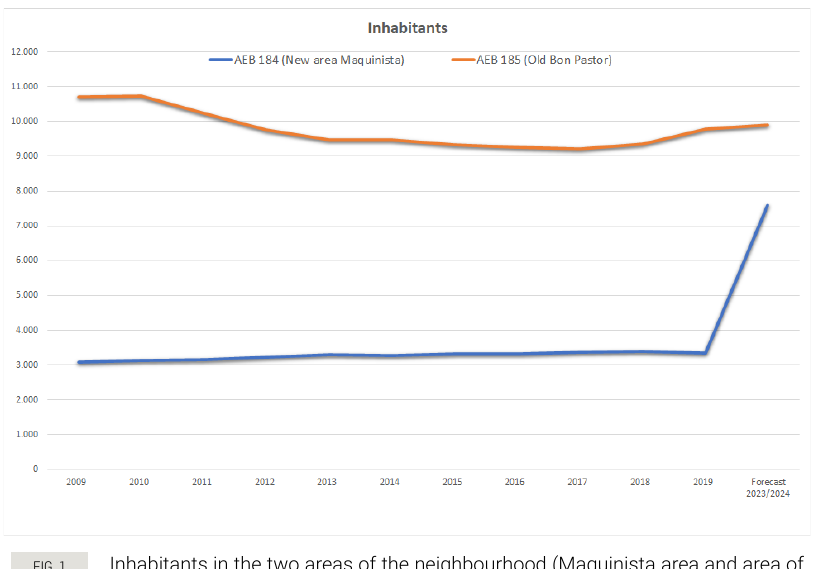
FIG. 1 Inhabitants in the two areas of the neighbourhood (Maquinista area and area of the old Bon Pastor). Own elaboration from Barcelona’s City Council